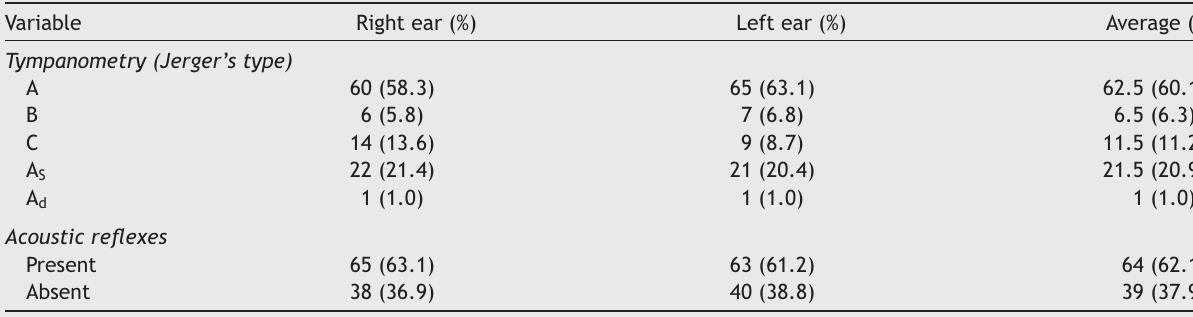
Impedance audiometric findings in the patients.